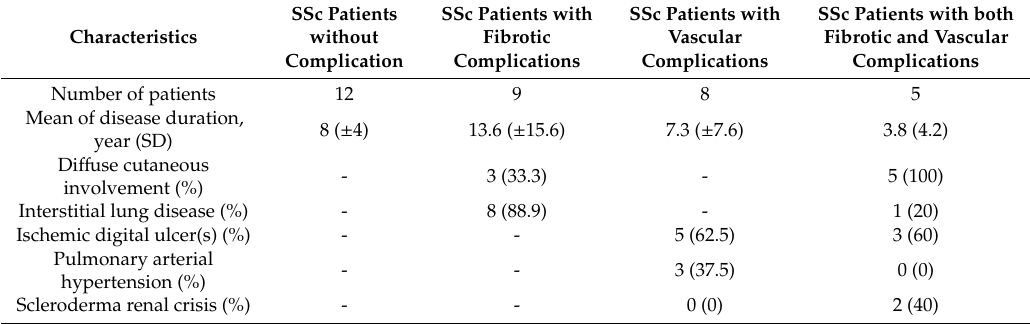
Table 2. Classification of SSc patients according to the type of complications.